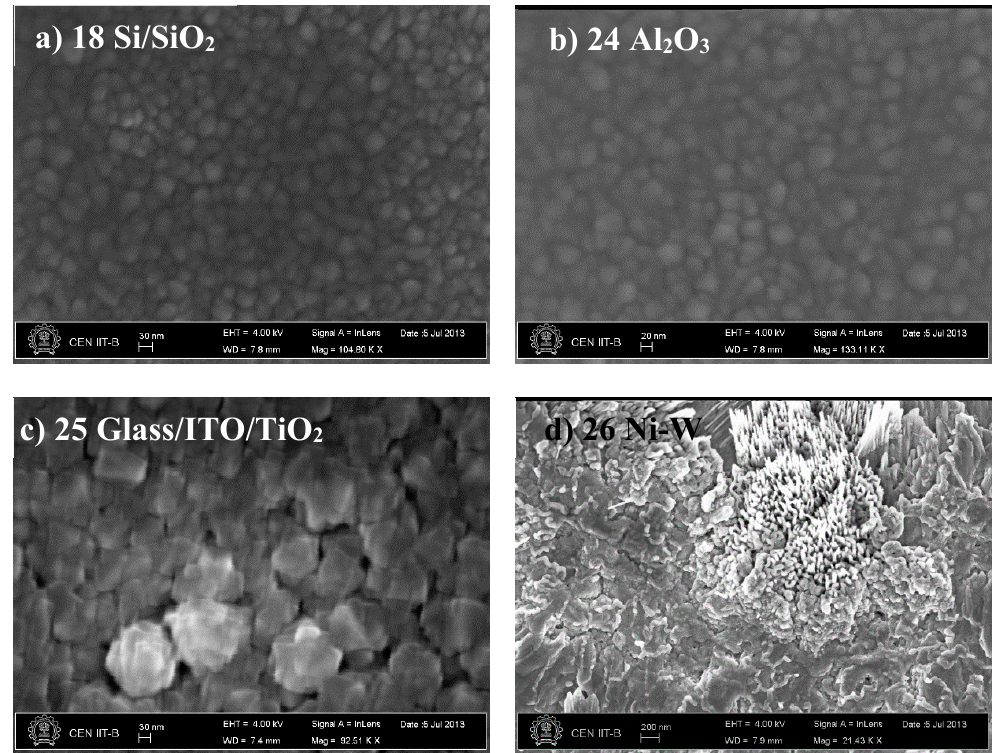
Crystals 2019 , 9 , x FOR PEER REVIEW 4 of 8 on Si/SiO 2 substrate using the same gas mixture, except for diborane, and same growth procedure [16]. The nucleation layer was about 10 nm thick. The layer immediately above the nucleation layer, about 0.2 micron thick, was of very high crystalline quality as seen from selective area diffraction (spotty pattern). The top layer, however, had more polycrystalline nature (rings diffraction pattern). Figure 1. SEM image of boron-doped p-type polycrystalline silicon thin film (Exp. 1) on ( a ) Si / SiO 2 , ( b ) Figure 1. SEM image of boron doped p-type poly crystalline silicon thin film (Exp. 1) on (a) Si/SiO 2 7 This aspect requires further investigation. Al 2 O 3 , ( c ) glass / ITO / TiO 2 , and ( d ) Ni-W. (b) Al 2 O 3 (c) Glass/ ITO/TiO 2 (d) Ni-W. 8